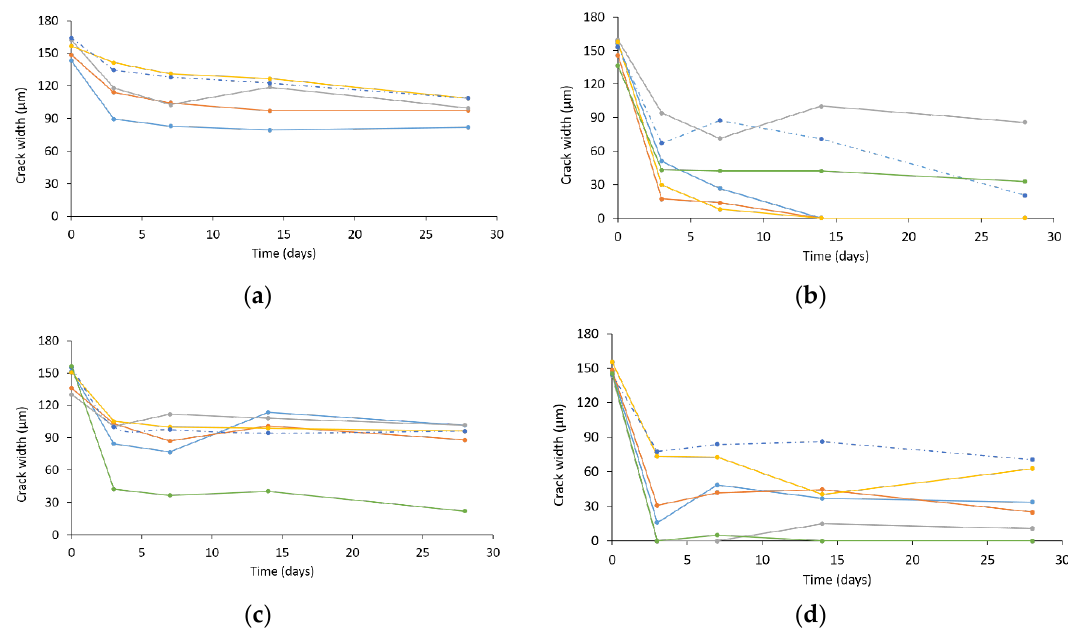
Figure 3. Evolution of crack width over time of ( a ) reference, ( b ) 0.2% SAP, ( c ) 2% HS-40 and ( d ) 0.2% SAP + 2% HS-40. The di ff erent curves represent the various specimens of each series that were